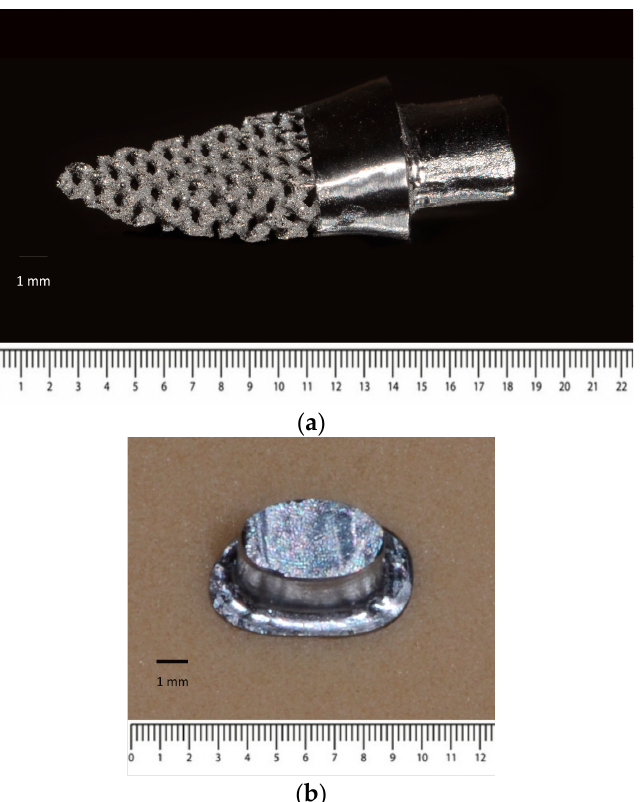
Figure 4. Solid and porous RAI, fabricated through L-PBF technique ( a ) RAI ( b ) implant placed in bone block.